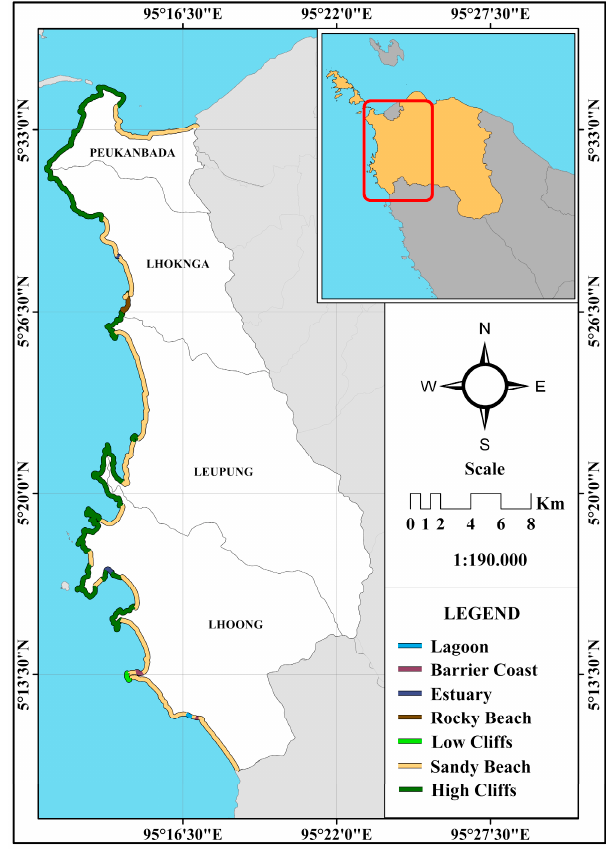
Figure 2. Geomorphology of west Aceh Besar district.